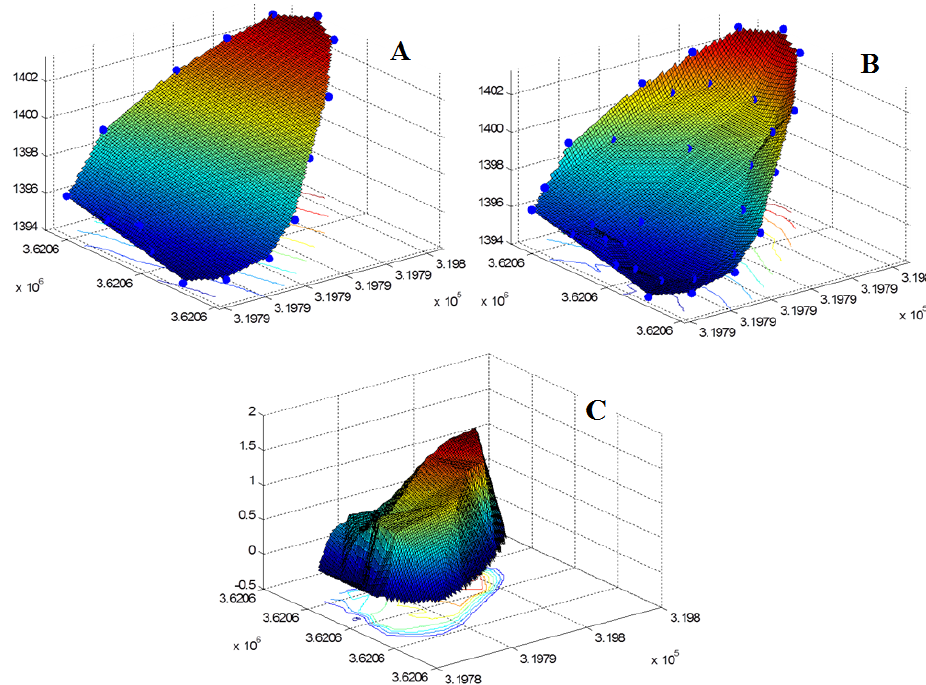
Fig. 8. Example of the modelling of the landslides surveyed in the field: A – original reference surface; B – landslide scar surface and C – model of the landslide slide material.